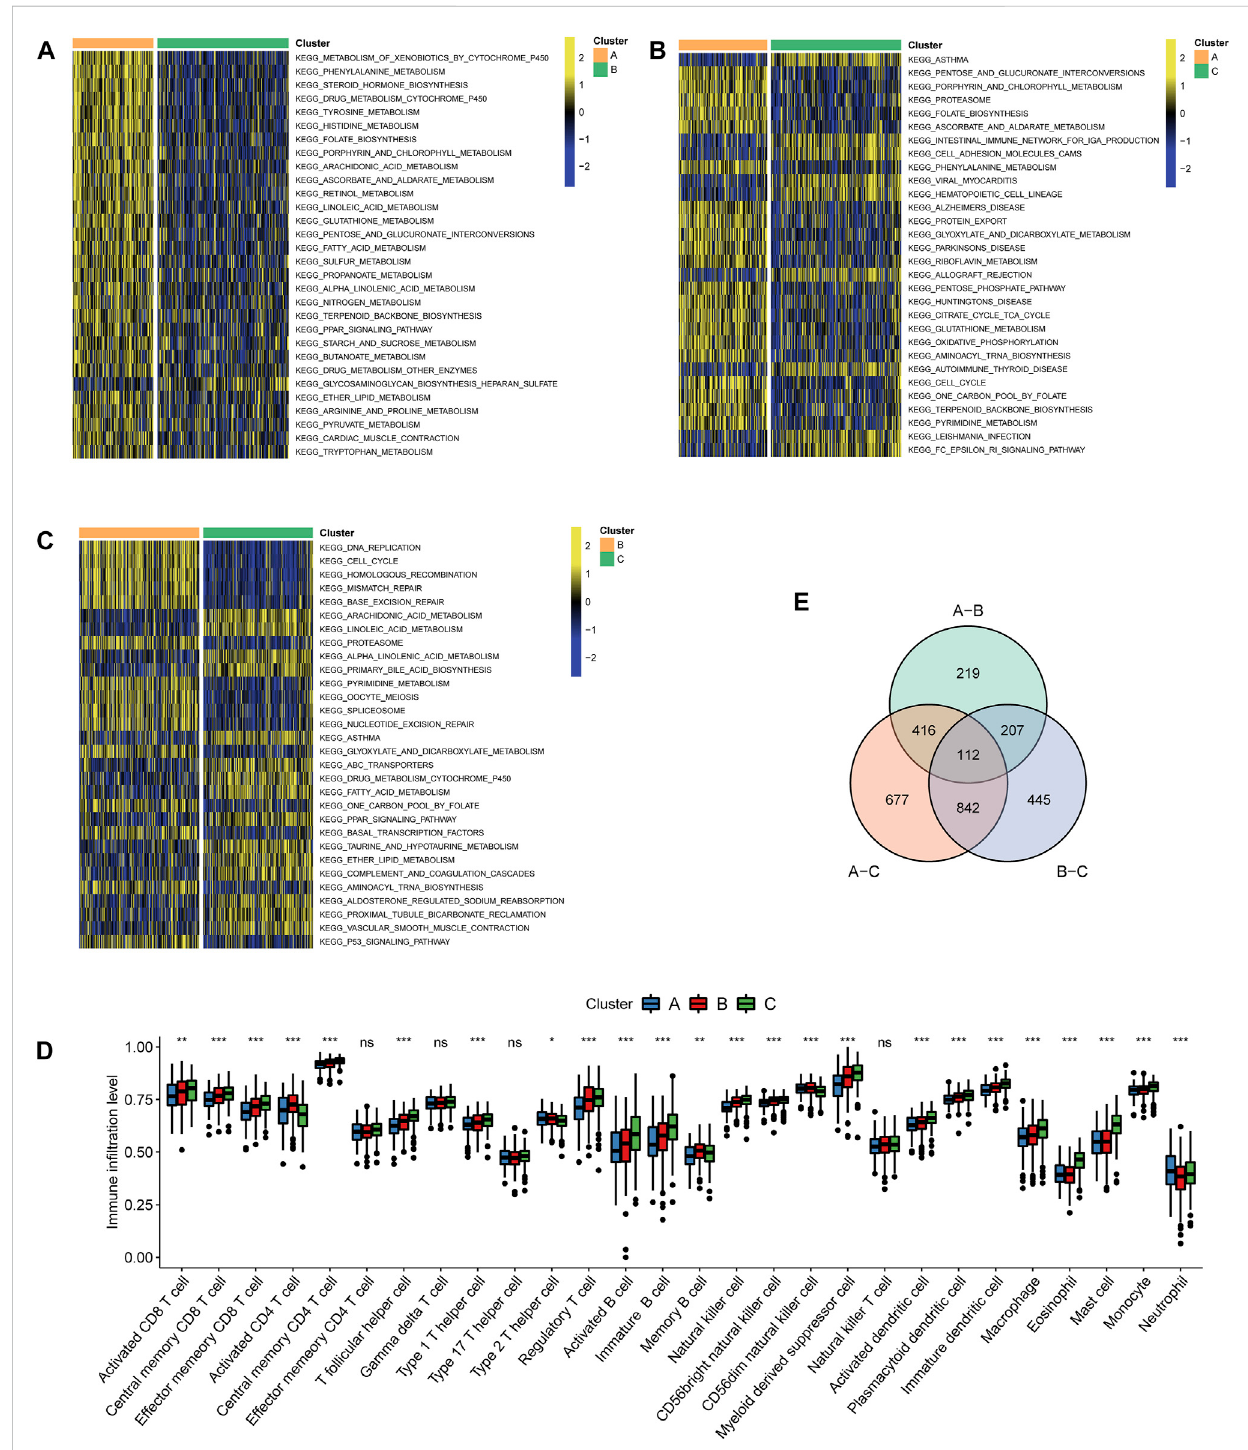
FIGURE 3 Characteristicsofbiologicalpathways andimmune-in fi ltratinglevelsamongclustering subtypes. Genesetvariation analysis forKyotoEncyclopedia of Genes and Genomes pathways between (A) Cluster A and Cluster B, (B) Cluster A and Cluster C, and (C) Cluster B and Cluster (C) . Yellow color represented active pathways, while blue color represented inhibited pathways. (D) Overlapped differentially expressed genes between each of the two clustering subtypes are shown by a Venn diagram. (E) Tumor immune-in fi ltrating levels of 28 cell types predicted by single-sample gene set enrichment analysis (*** p < 0.001, ** p < 0.01, and * p < 0.05; ns: no signi fi